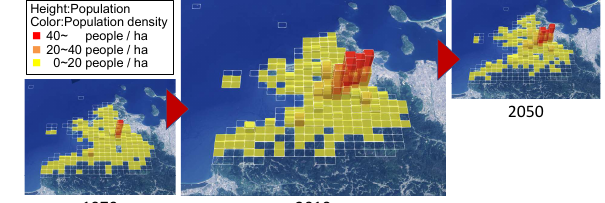
Figure 4. Time Series Visualization of the changes in population